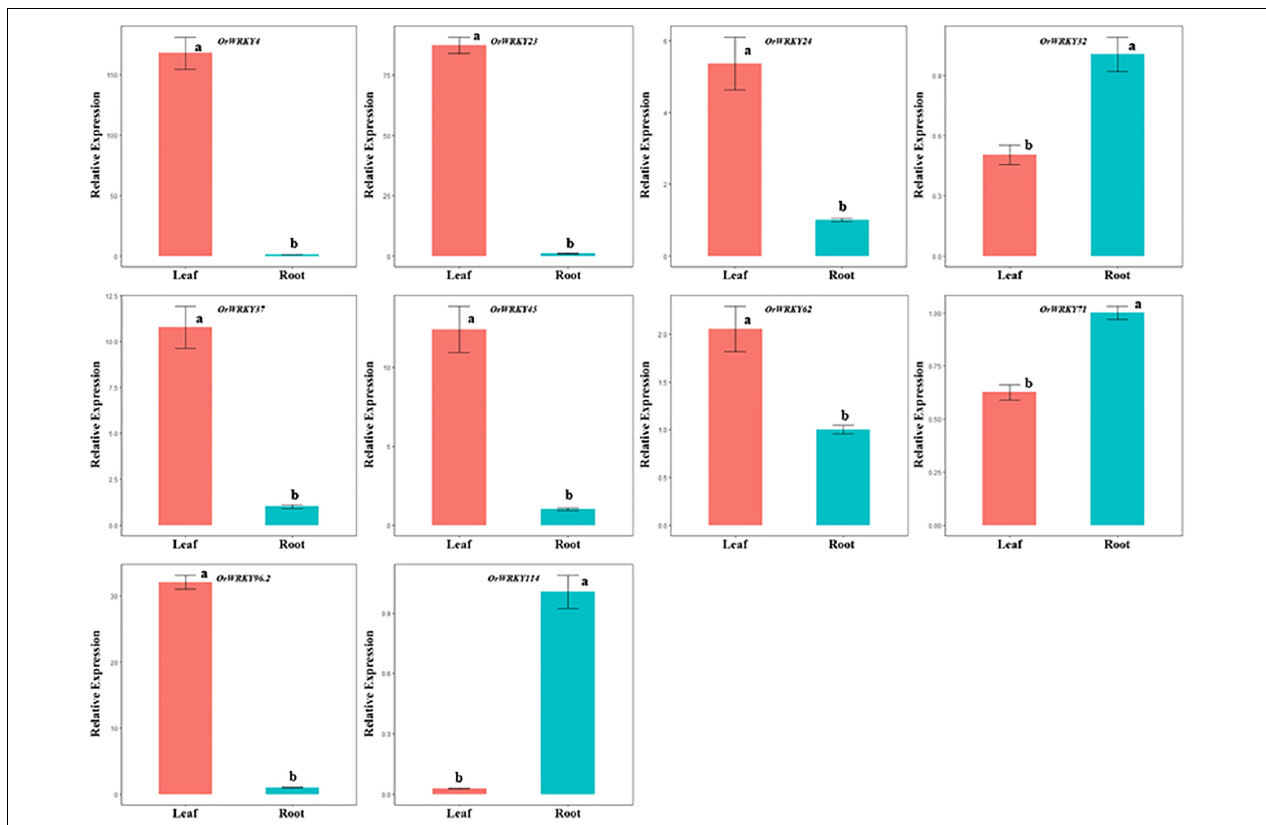
FIGURE 3 | Expression patterns of 10 OrWRKY genes in leaves (red) and roots (green) tissues. The y -axis represents the relative expression levels of OrWRKY genes using 2 − (cid:49)(cid:49) CT method. The x -axis shows different tissues. Error bars indicate standard deviations (mean ± SD) of three independent replicates. The histogram bars labeled with different letters (a and b) above histogram bars show significantly different [least significant difference (LSD) test, P <